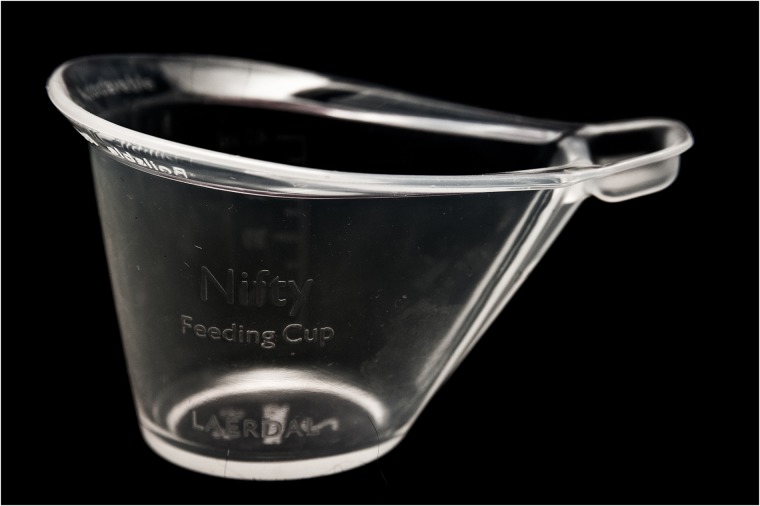
Nifty cup.Photo credit: Seattle Children’s/Erik Stuhaug.